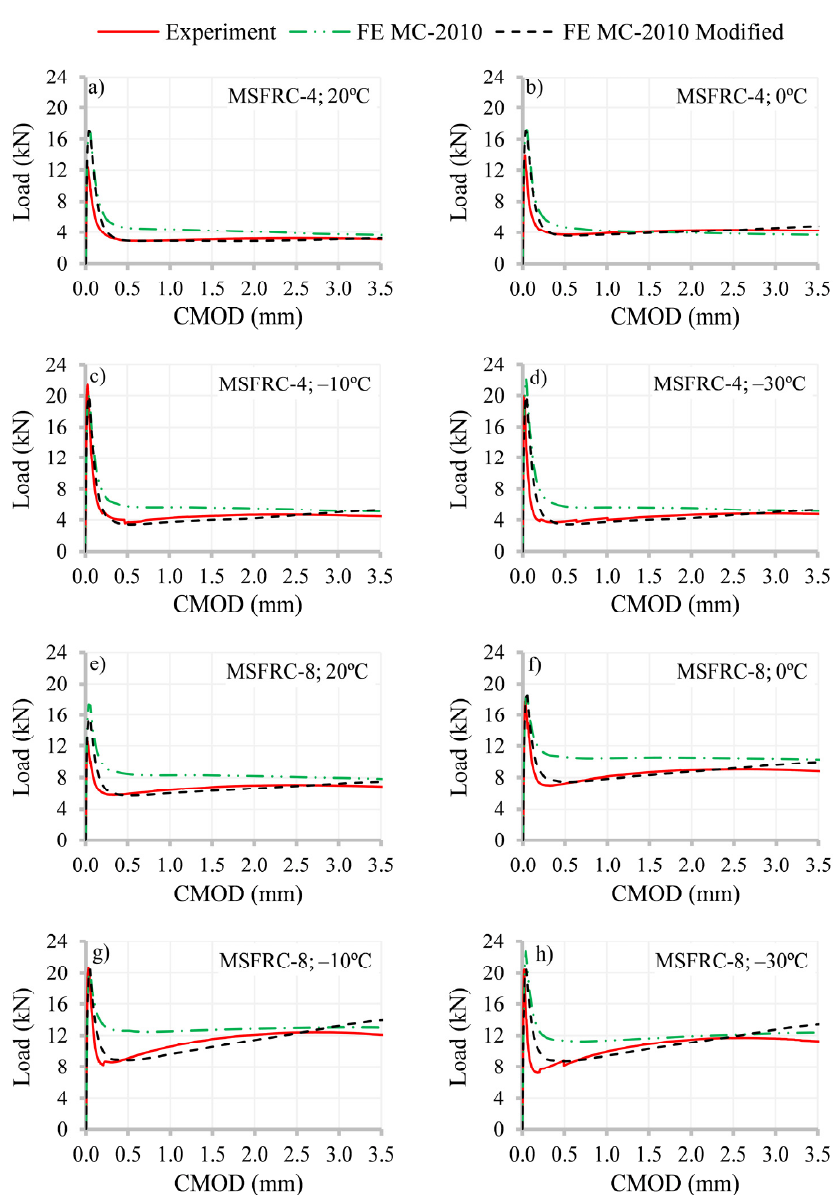
Figure 8. Results for MSFRC-4 and MSFRC-8 at studied temperatures in terms of “load–CMOD”. Table 3. f RNL / f REXP ratio for MSFRC-4 and MSFRC-8 at studied temperatures.